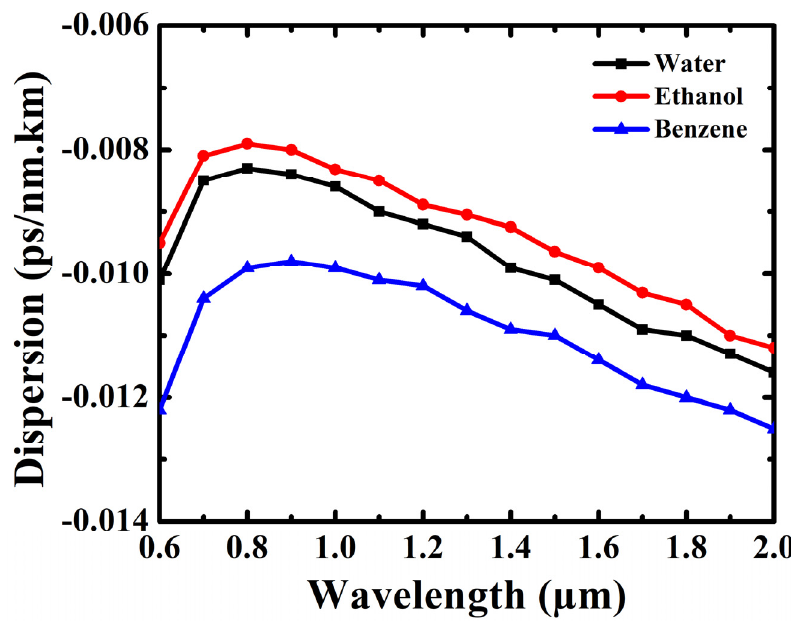
Figure 8. Chromatic dispersion of the PCF sensor with water, ethanol and benzene, for different operating wavelengths.